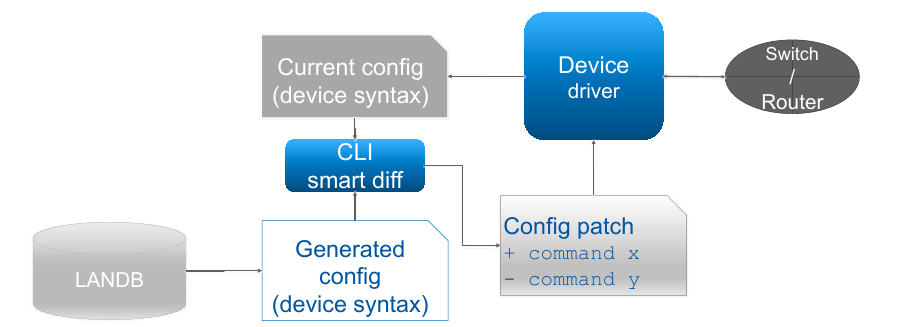
Figure 2: Current network configuration management architecture.